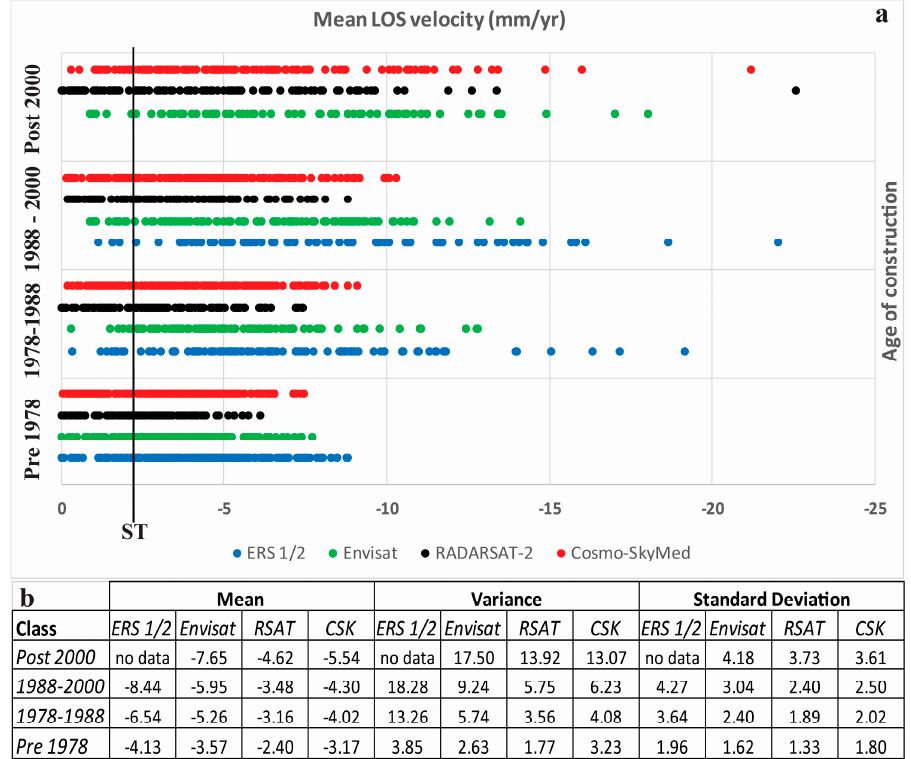
Figure 7. ( a ) Age of construction of the selected buildings compared to the mean LOS velocity of the DInSAR data; ( b ) Mean, variance and standard deviation values for each class and each sensor. The ERS 1/2 and Envisat series are modified from Solari et al. [6]. The vertical black line represents the defined stability threshold (ST).